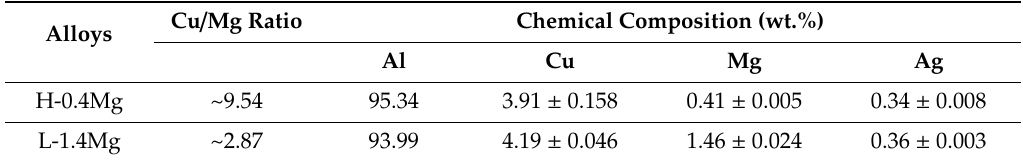
Table 1. Average chemical composition (wt.%) of the experimental